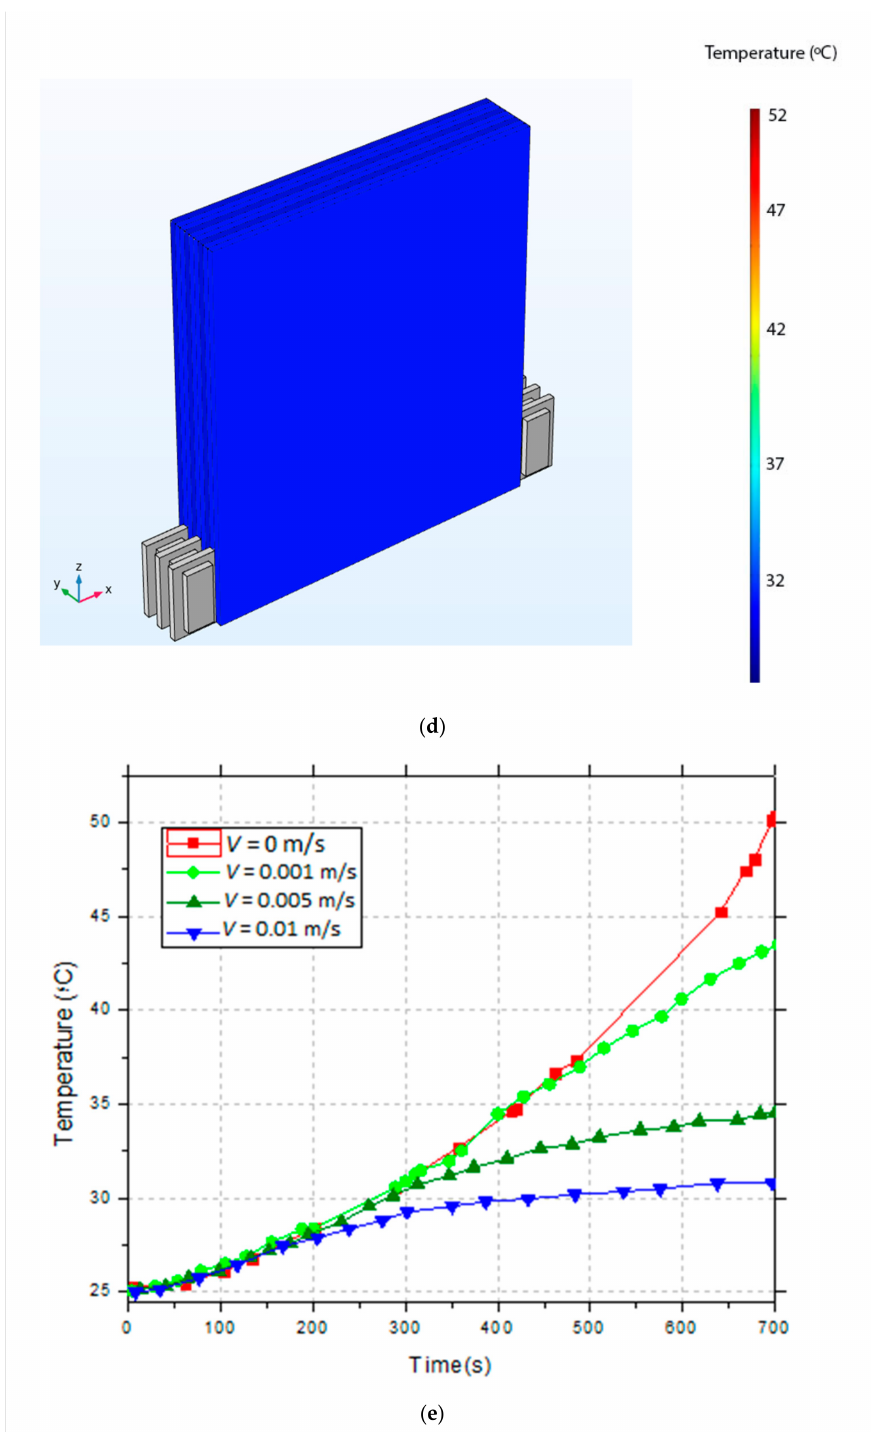
Figure 8. Performance of the liquid-cooling system under di ff erent coolant flow rates for a single cycle: ( a ) Temperature distribution inside the LiFePO 4 battery stack without any coolant flow; ( b ) Temperature distribution inside the LiFePO 4 battery stack under coolant flow rate of V = 0.001 m / s; ( c ) Temperature distribution inside the LiFePO 4 battery stack under coolant flow rate of V = 0.005 m / s; ( d ) Temperature distribution inside the LiFePO 4 battery stack under coolant flow rate of V = 0.01 m / s; ( e ) Temperature variations under the impact of di ff erent liquid flow